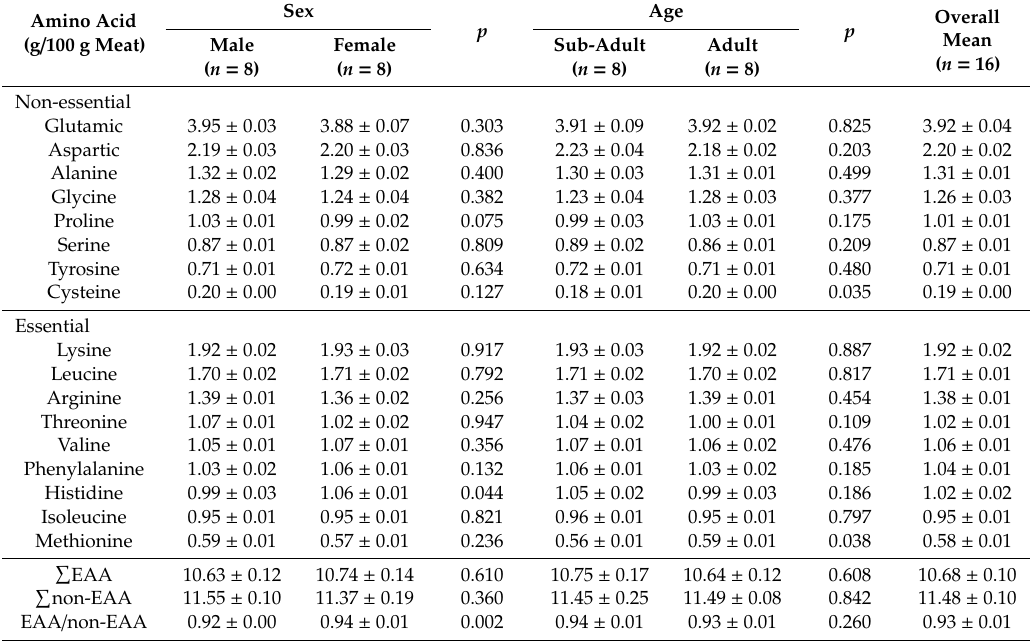
Table 3. Amino acid composition and content of axis deer longissimus thoracis , as influenced by sex and age (mean ±